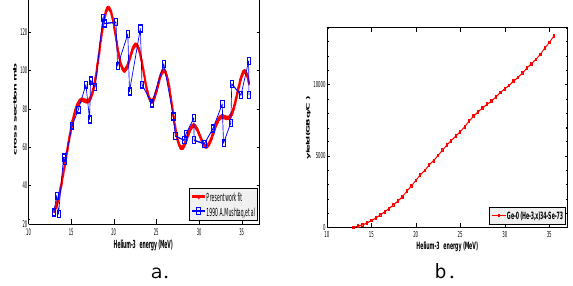
Figure 7 : a. Excitation function for the reaction nat Ge ( 3 He,x) 73 Se. b. Isotopes production yield for the reaction nat Ge ( 3 He,x) 73 Se 4 -Production by alpha particles a-70Ge (α, n)73Se The Alpha particles induced reaction70Ge (α,n)73Se with range of energy (7 to 37) MeV Fig.8.a. According to V.N.Levkovskij (10). The isotopes production yield results were shown in Fig.8. b. which was determined by equation (2) and the calculated stopping power values by using SRIM code (4)